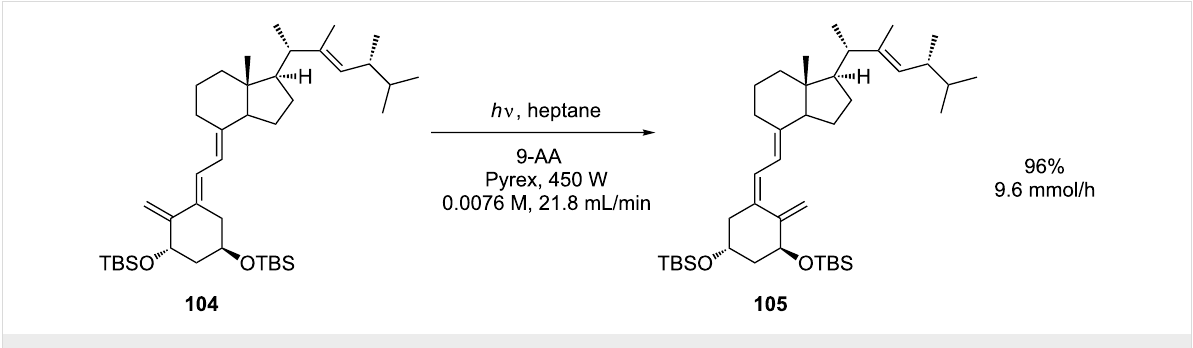
Scheme 36: Photoisomerisation en route to a vitamin-D derivative.